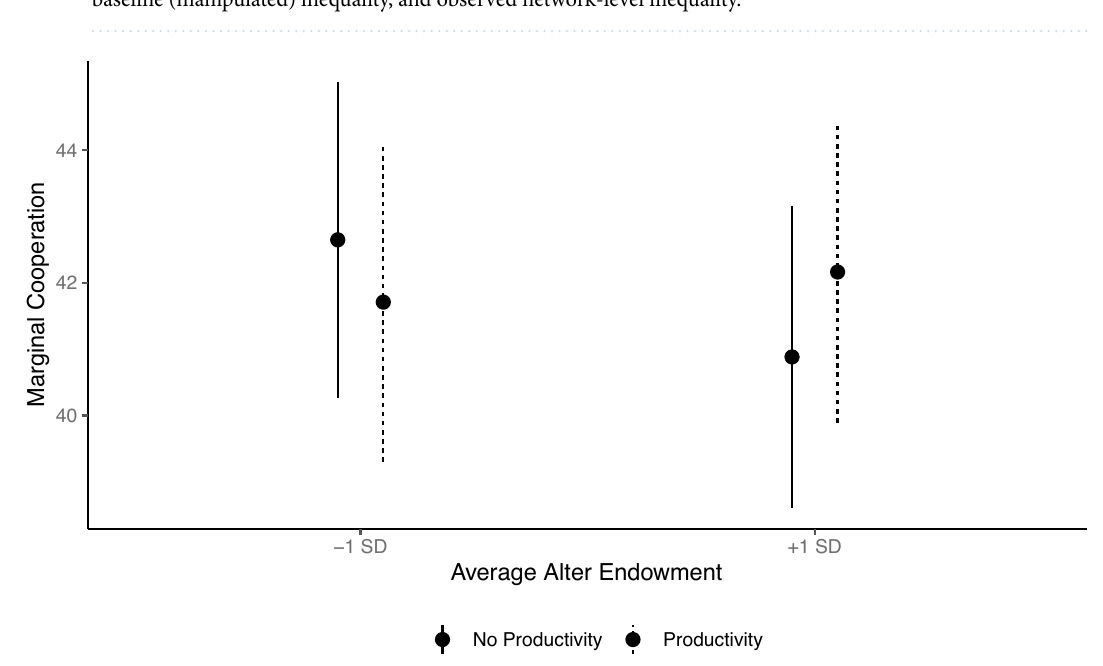
Figure 5. Marginal means from Model 4 of Table 1 illustrating the interaction between wealth productivity and average alter